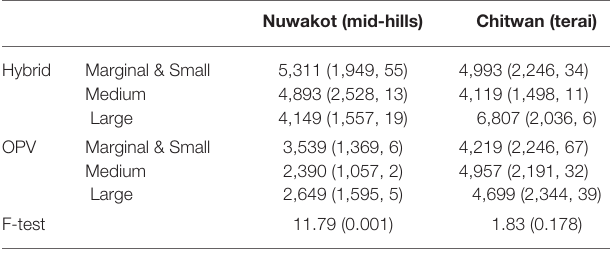
TABLE 4 | Rice yield variation by seed type, farm size and study areas, Nepal (kg/ha, farmer reported).